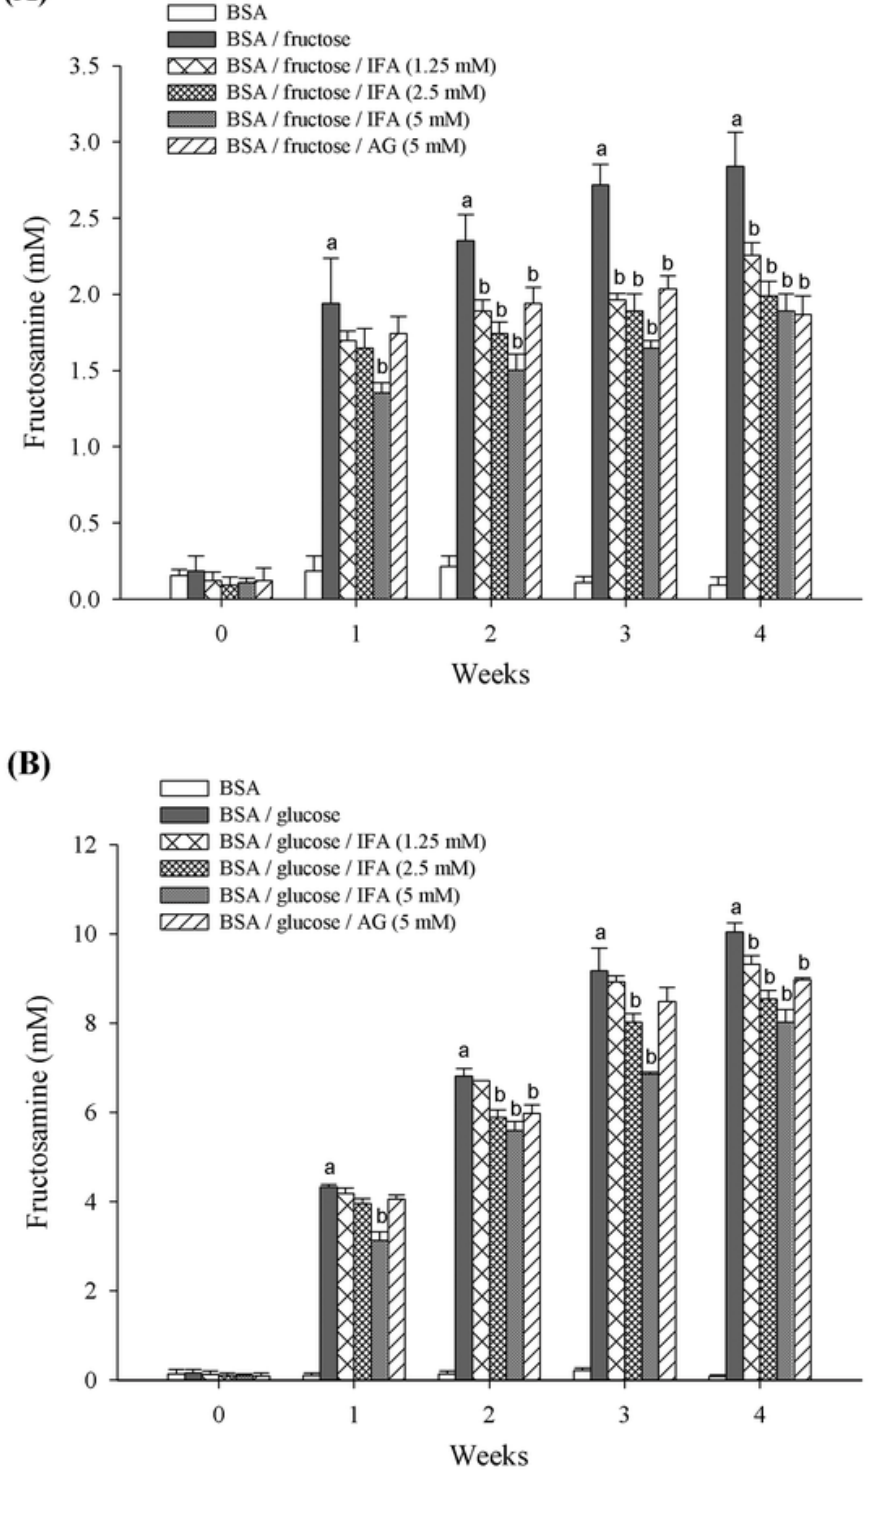
Figure 3. The effect of IFA on the Amadori production in BSA/fructose ( A ) and BSA/glucose ( B ) systems. Results are expressed as mean ± SEM (n = 3). a p < 0.05 when compared to BSA, b p < 0.05 when compared to BSA/fructose or